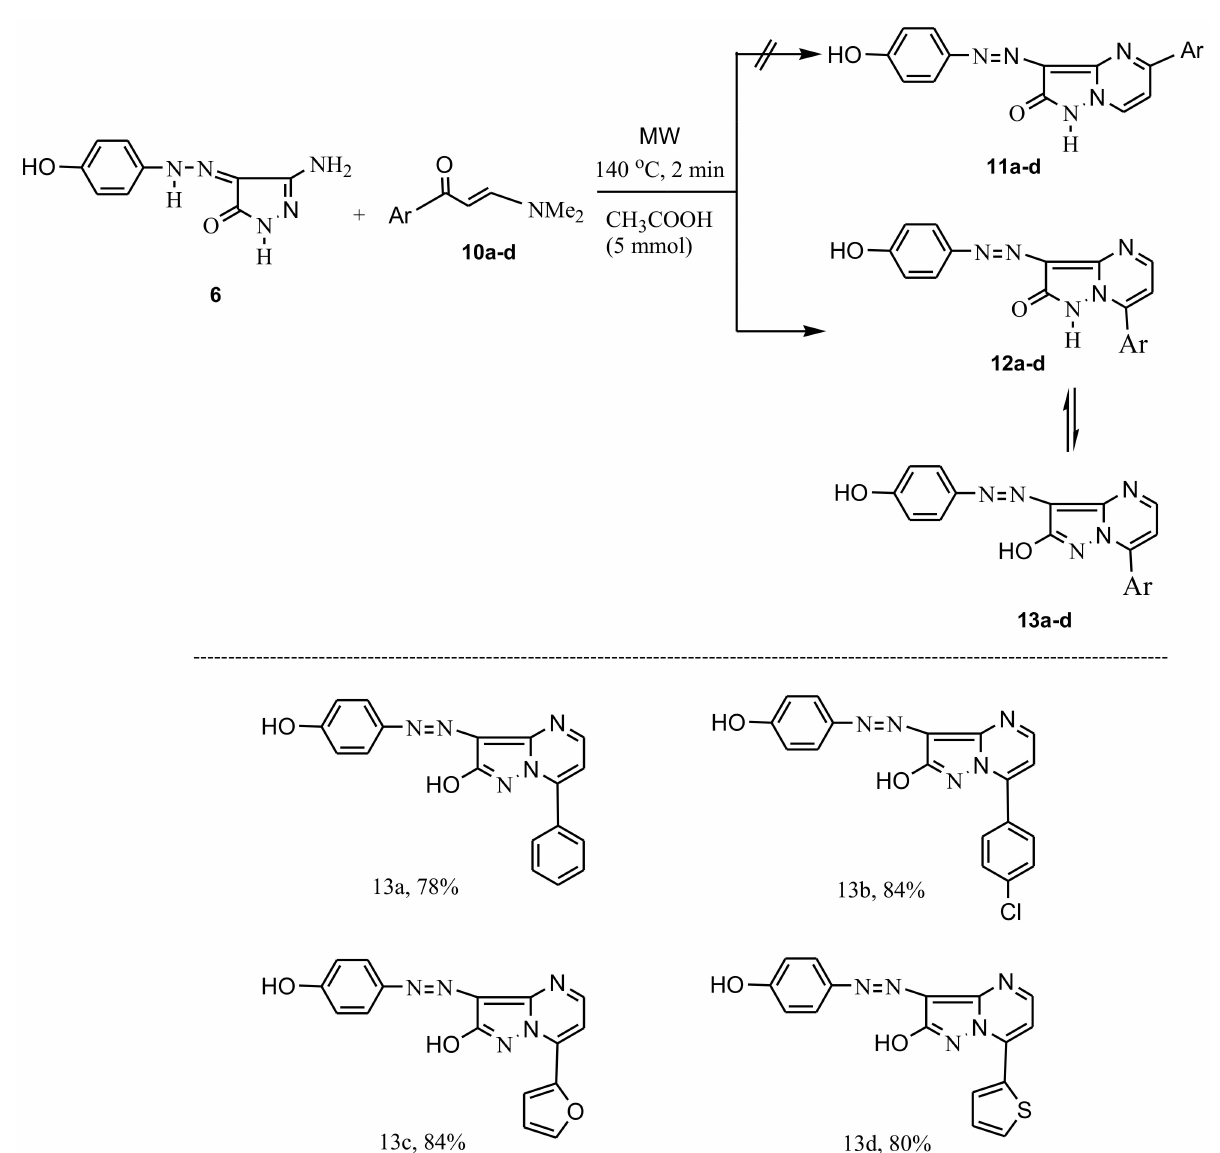
Scheme 3. Synthesis of compounds 13a – d